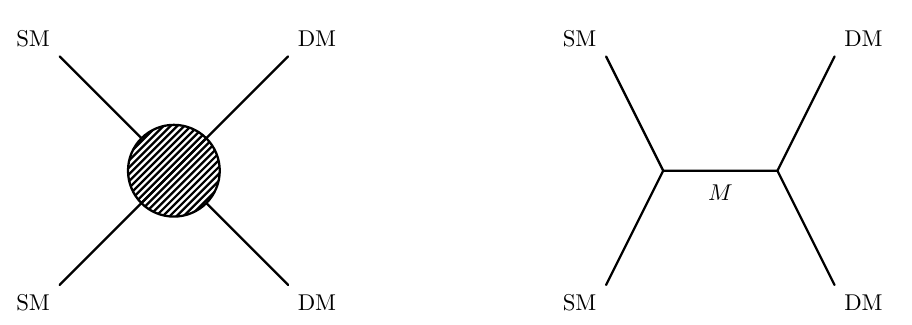
Figure 1. Dominant dark matter production by the exchange of a mediator (cid:12)eld M . Note that the dark matter particle is stabilized by an odd Z 4 charge, while Standard Model (cid:12)elds carry even Z 4 charges and the mediator is uncharged. Importantly, the existence of such a stabilizing discrete symmetry is a direct consequence from the extra dimensions of string theory.